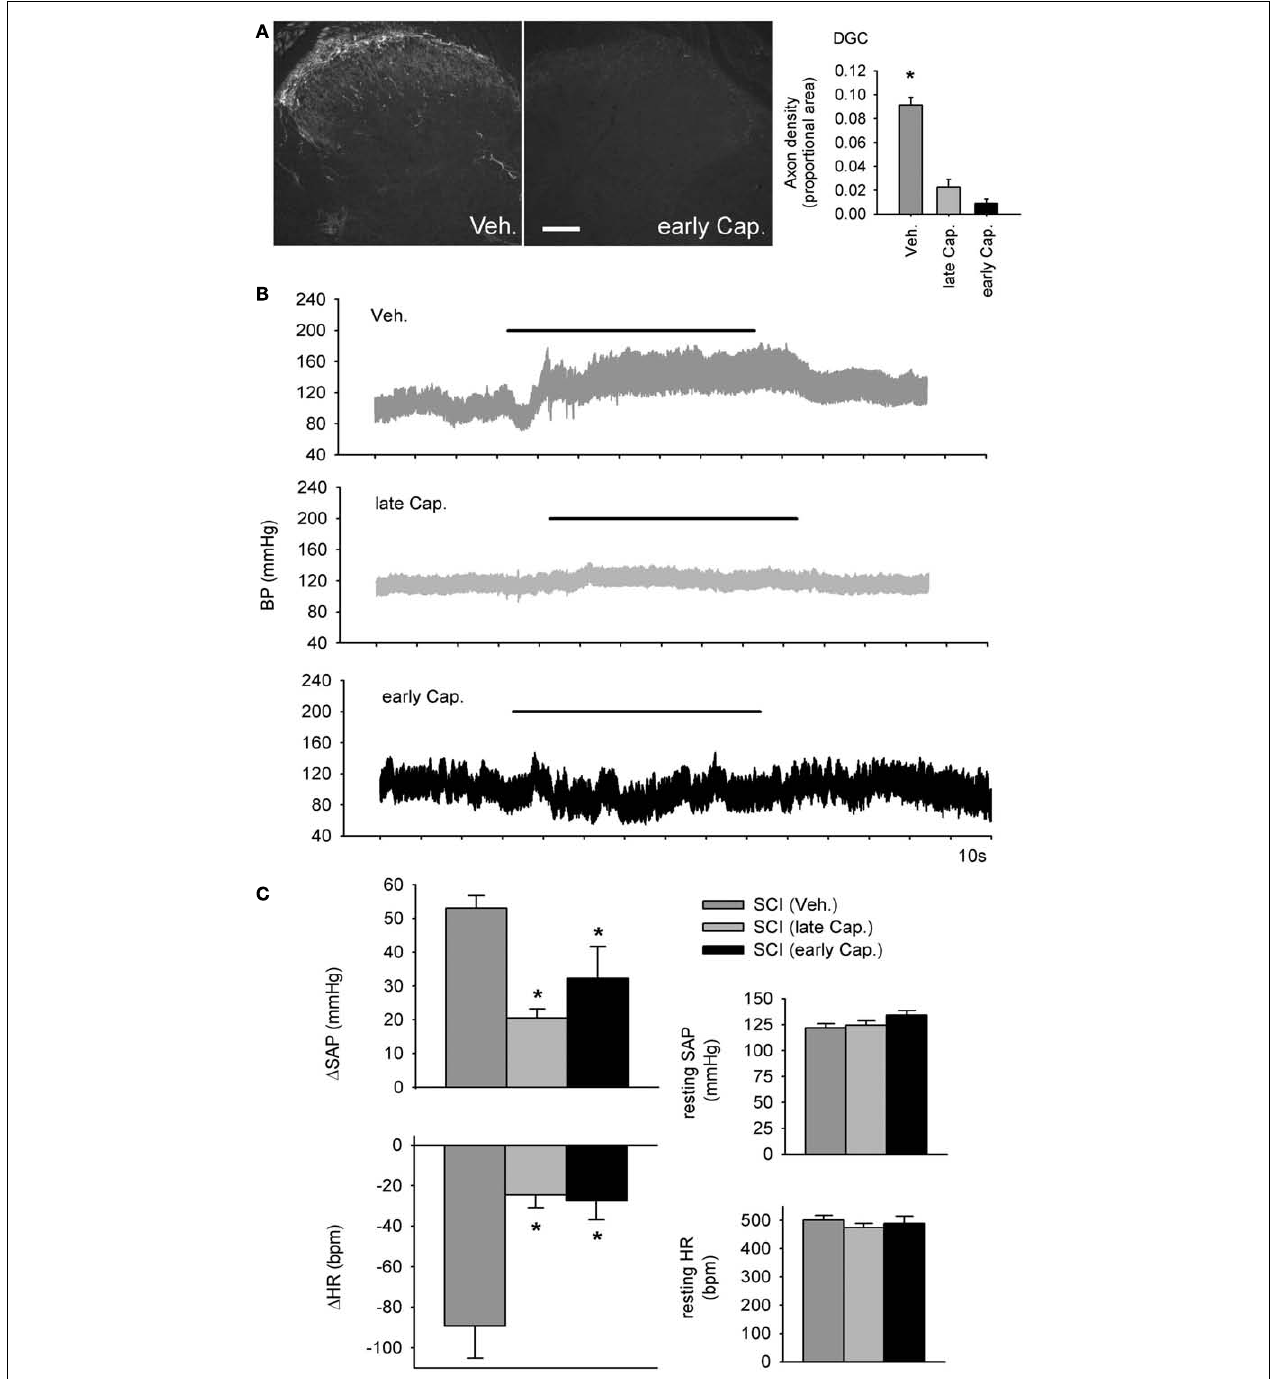
colo-rectal distension (horizontal bars) from animals treated with intrathecal vehicle (Veh.), early capsaicin (48h followingT3 SCI, early Cap.), and late capsaicin (48h prior to physiological recording, 28days post-T3 SCI, late Cap.). (C) Quantitative cardiovascular responses to CRD in vehicle and capsaicin-treated rats, 30days post-SCI. Capsaicin treatment, whether administered 48h or 28days after SCI, mitigated CRD-induced increases in systemic arterial pressure (SAP) and decreases in heart rate (HR). Resting SAP and HR were unaffected by intrathecal capsaicin. Asterisks: P < 0.05, one-way